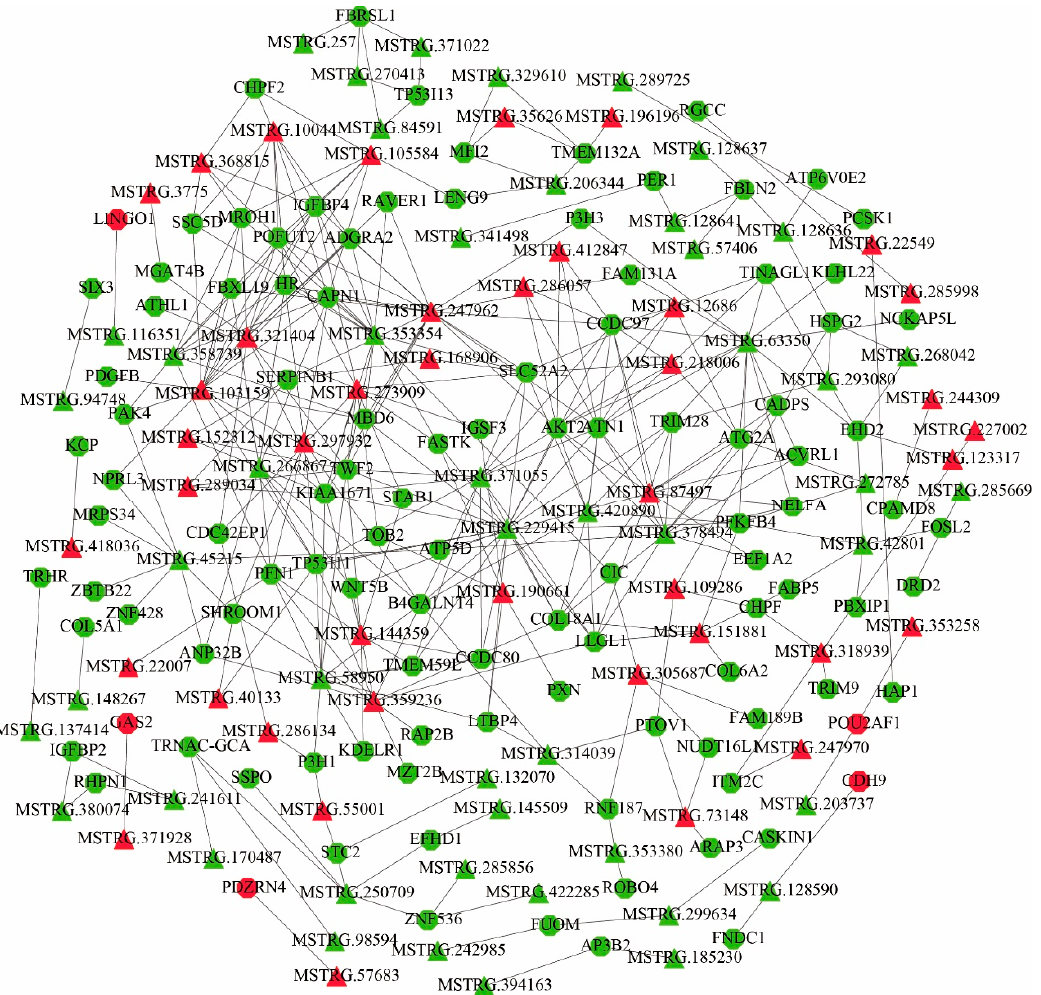
Figure 6. Construction of the lncRNA–mRNA co-expression network between the SP and LP groups. Red and green represent upregulated and downregulated, respectively. Octagons and triangles represent mRNAs and lncRNAs, respectively.